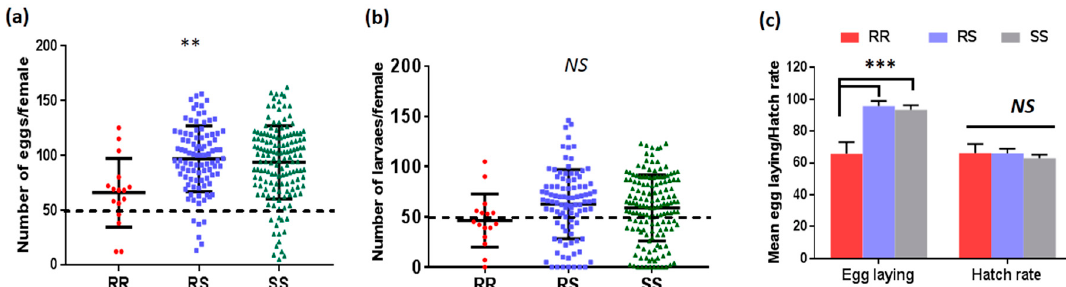
Figure 1. Fecundity and fertility of females with different genotypes at the L119F locus of the GSTe2 gene: ( A ) Comparison of the number of eggs laid by field-collected female Anopheles funestus between the L119F-RR, L119F-RS and L119F-SS genotypes; ( B ) number of larvae produced by females from each genotype; ( C ) hatching rate between the three genotypes. Each dot represents a single egg-laying female. Median value with interquartile range is shown for each distribution. Dotted line indicates females for which at least 50 eggs or larvae were obtained. ** Difference between genotypes was significant ( p < 0.01) in term of eggs laying by Kruskal–Wallis non-parametric test whereas the number of larvae produced and the hatch rate did not differed significantly. ***: significant difference at p < 0.001; NS: not significant